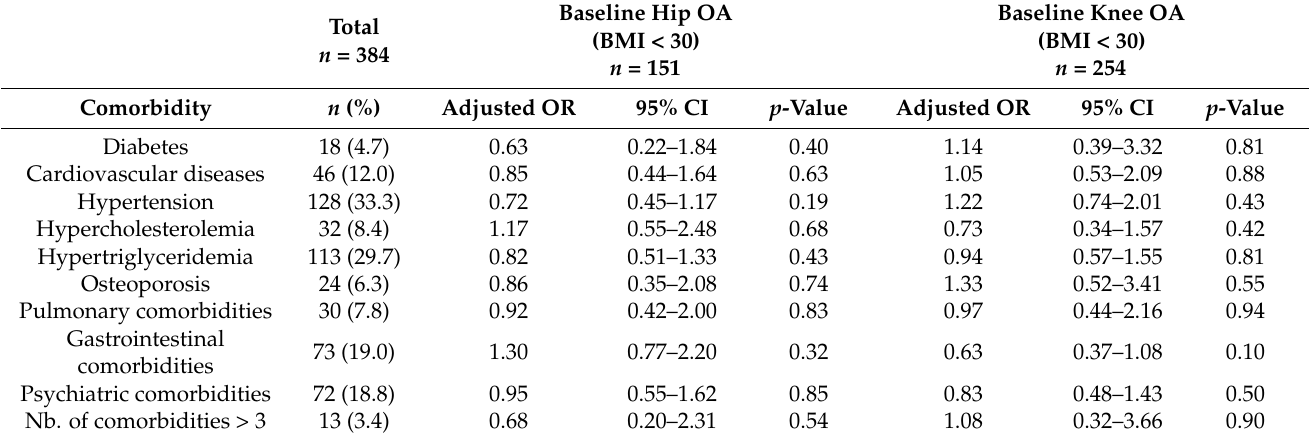
Table 2. Relationship of comorbidities with hip or knee OA at baseline; absence of comorbidity is the reference category. Odds ratio adjusted for age, gender and